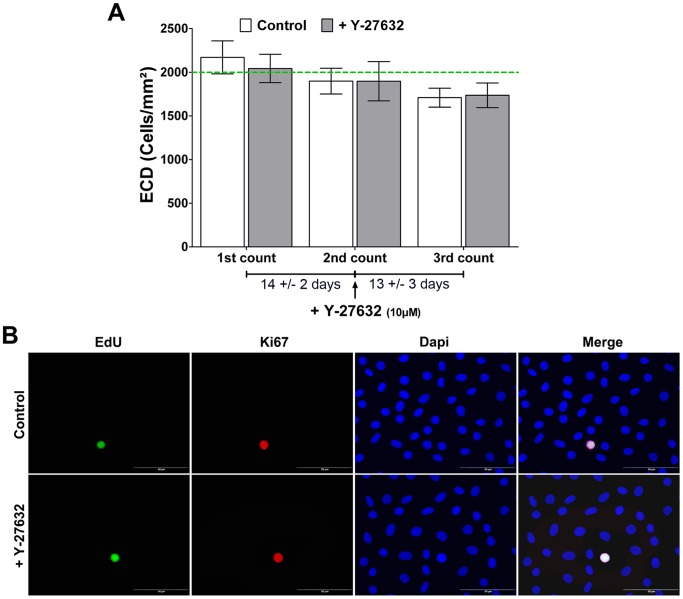

Ex vivo proliferation assessment.(A) Proliferation evaluation by Endothelial Cell Density (ECD) determination. ECD after corneas procurement is comparable in the control and the treated corneas. A cell loss of 12% and 9% for control and treated corneas respectively is observed after corneas storage during 14+/−2 days with no significant differences between both groups. A similar cell loss is observed in control and Y-27632 treated corneas after 13±3 days of preservation with respectively 8% and 9%. The threshold of 2000 cells/mm2 conventionally used to deliver grafts for penetrating keratoplasty is shown as a green dotted line. Values are means +/− SEM (n = 6 pairs). (B) Proliferation evaluation by EdU incorporation and Ki67 immunostaining. Only few EdU and Ki67 positive cells were detected in both groups. (Magnification 40x).